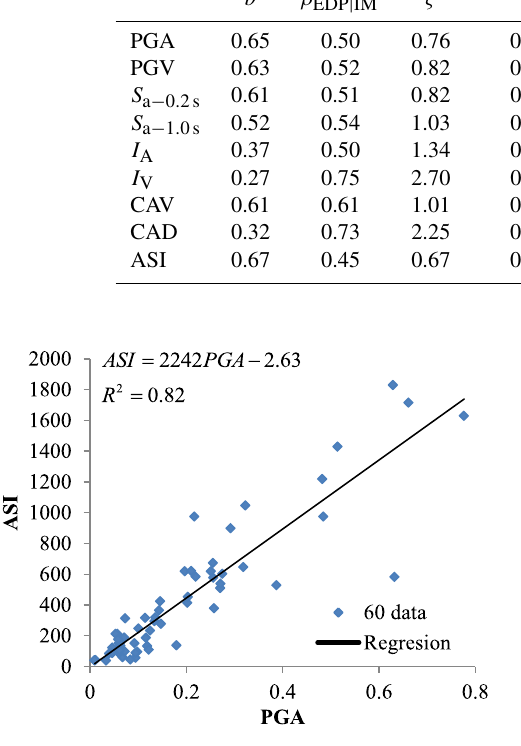
Figure 6. Correlation between ASI and PGA.